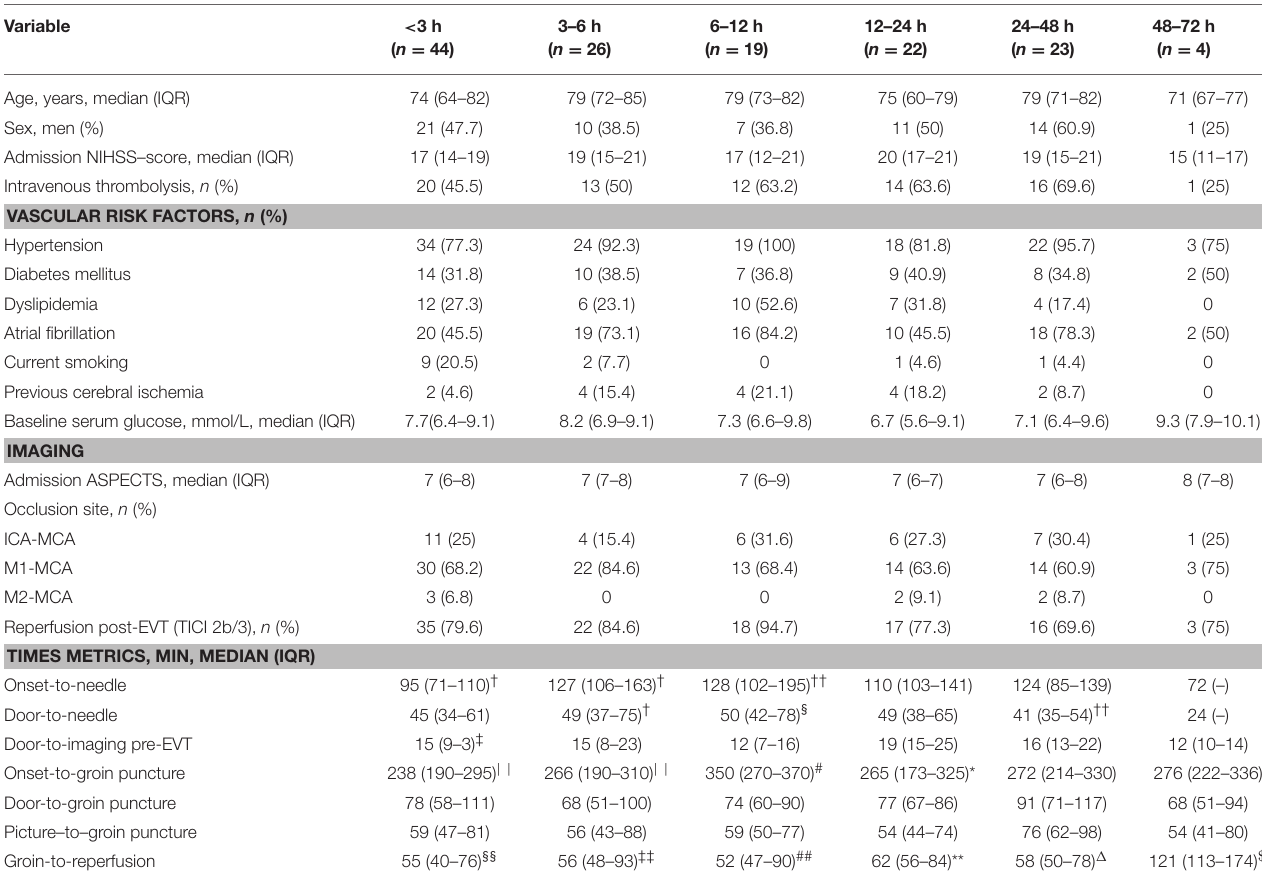
TABLE 1 | Clinical and imaging characteristics by general anesthesia time intervals.